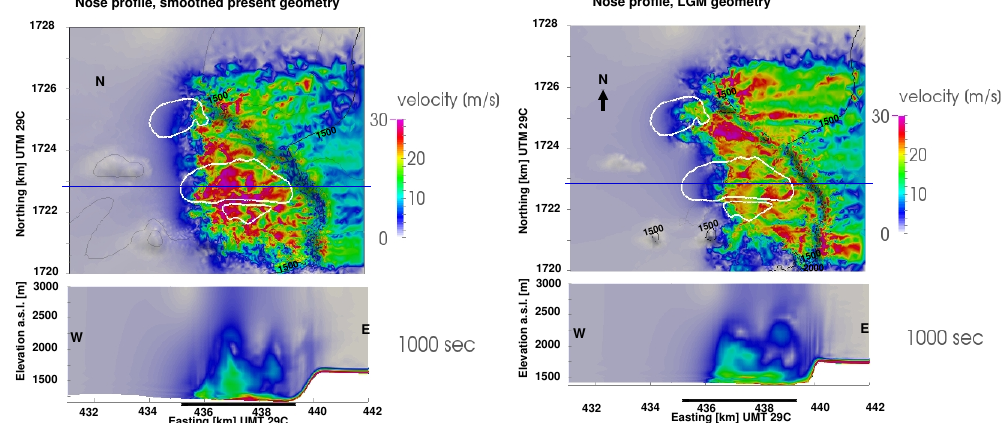
Figure 11. Velocity magnitude 5m above the surface and in a vertical cross section from east to west through the valley (marked by the horizontal blue line in plan views) of the simulation using the nose-shape (Eq. 5) profile on a smoothed present-day terrain (left) and on the LGM terrain (right) displayed at 1000s into the simulation. The white lines in the plan view and the black bar under the cross section denote the positions of the BIAs. The cross sections are stretched vertically by a factor of 2. The velocity scales are truncated at 30ms − 1 .